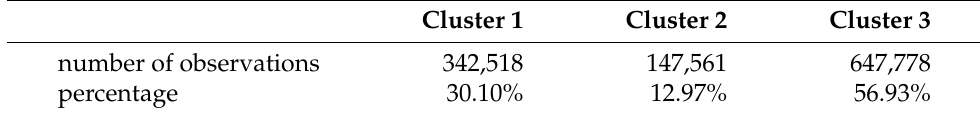
Table 2. Size and percentage for each of the three optimal